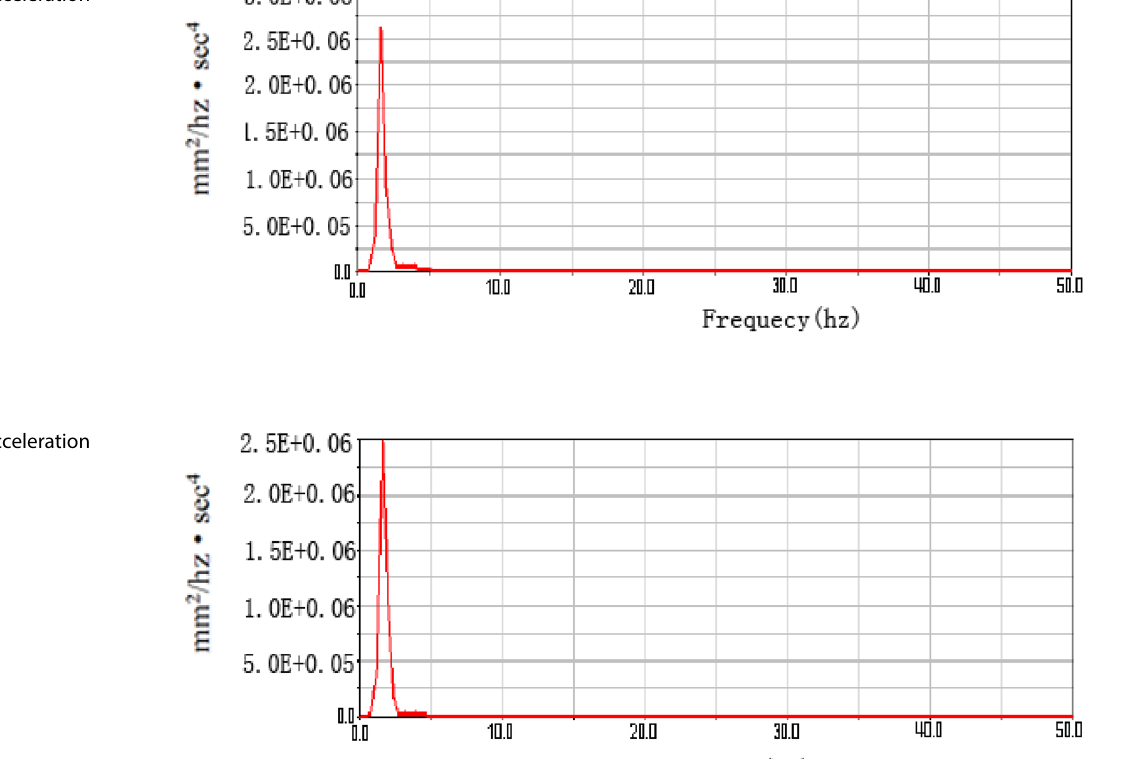
Fig. 12 Test 7. Acceleration Response Curve